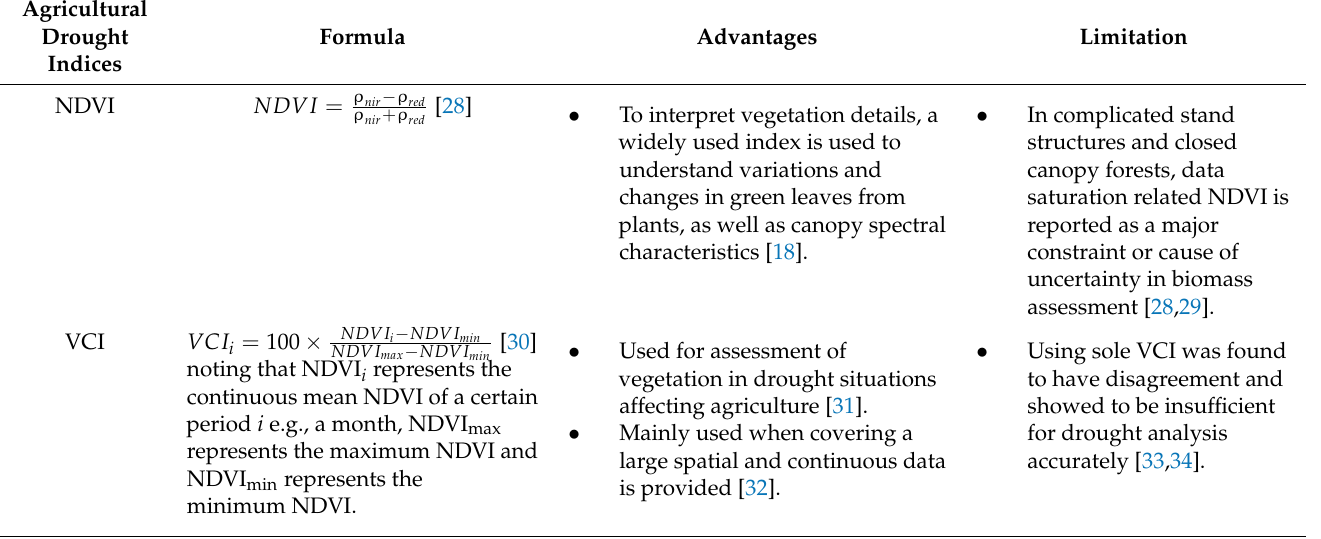
Table 1. Influential satellite-based indices useful in agricultural drought assessment.